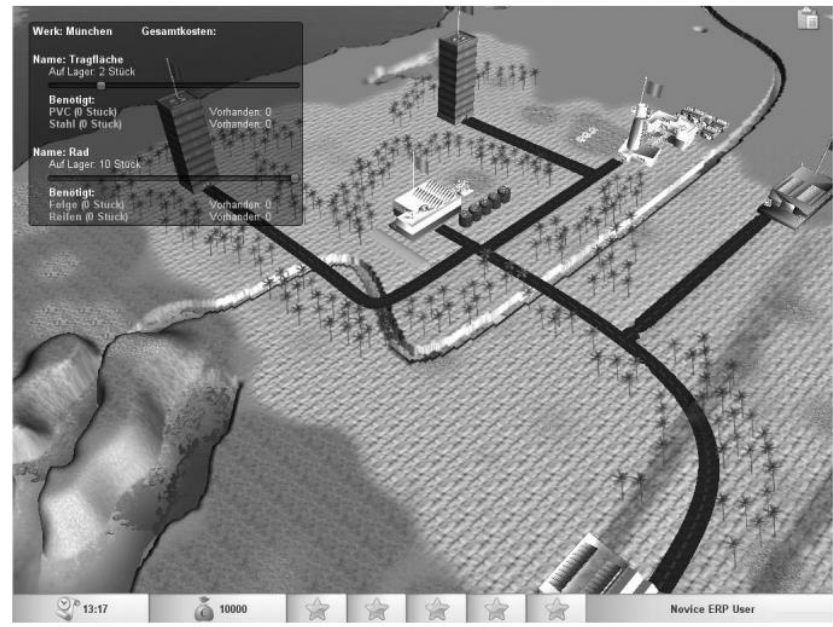
Fig. 4. Screenshot of the user interface of the ERP gamification prototype by